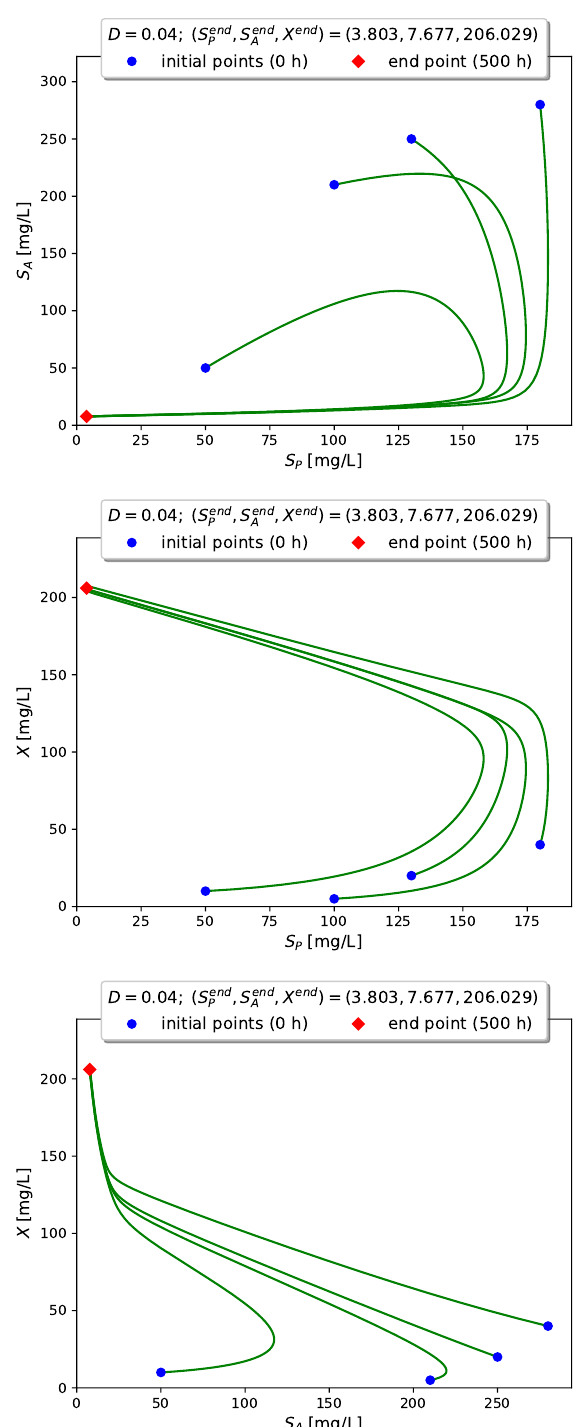
Figure 5. Example 1. Projection of trajectories of system (1)–(3) in different phase planes with several initial